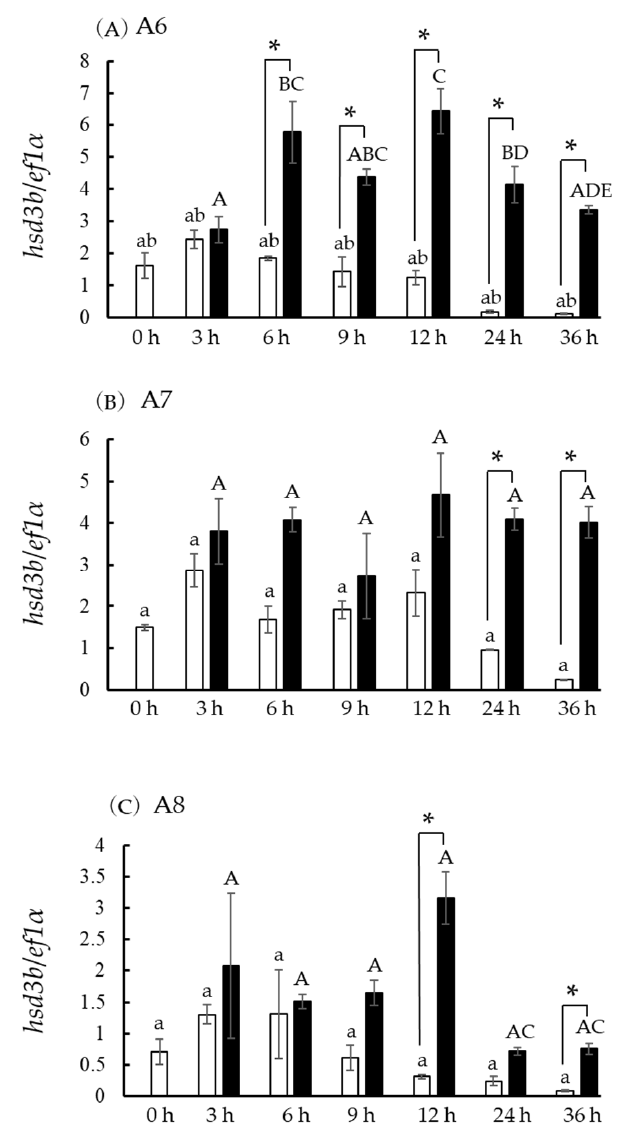
Figure 9. hsd3b expression in incubated ovarian follicles from A6, A7, and A8. Levels of mRNA from follicles incubated in media alone (white column) and in 500 μ g/mL SPE (black column). Panels ( A ), ( B ), and ( C ) indicate individuals A6, A7, and A8, respectively. Ovarian follicles from A6, A7, and A8 were used at 8 h after injection of LHRHa. Each vertical bar represents the mean ± SE of three replicate incubations. Different letters (control: a, SPE: A) represent a significant difference among groups ( p < 0.05). * p < 0.05.